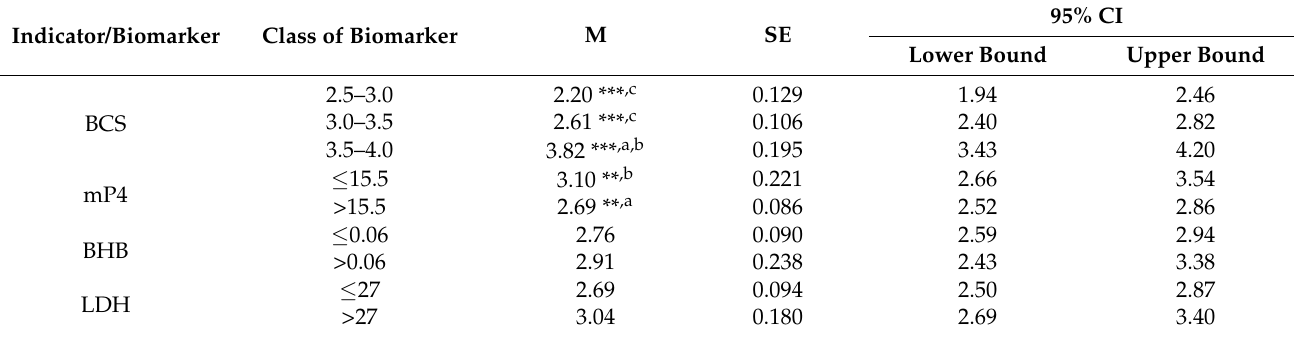
Table 3. Means and standard errors of the mean of biomarkers registered from the day of oestrus to 7 days post-oestrus based on the number of